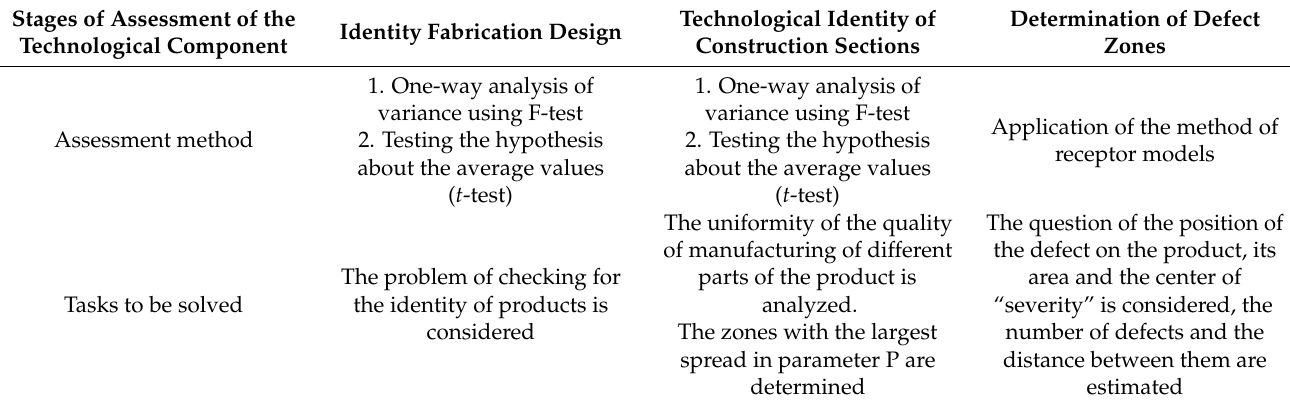
Table 1. Questions to evaluate the stability of the manufacturing technology of the